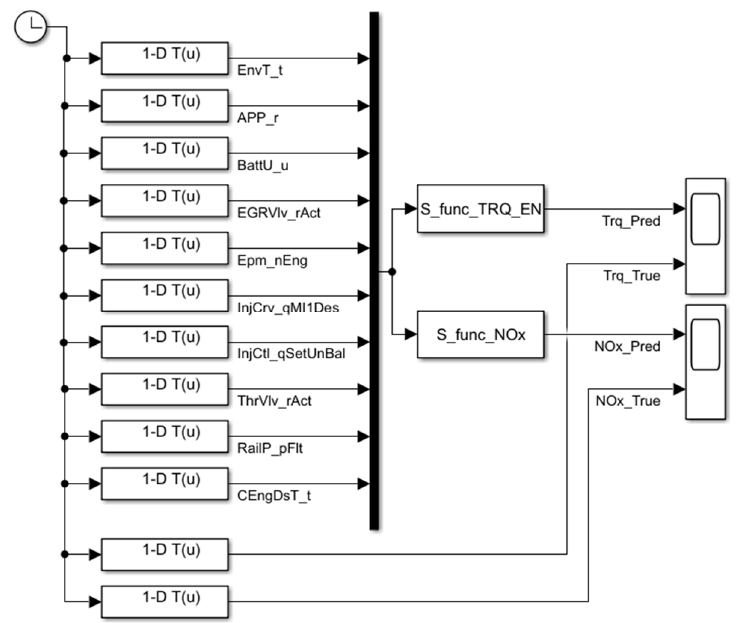
Figure 3. Engine Torque and NOx Emission Validation